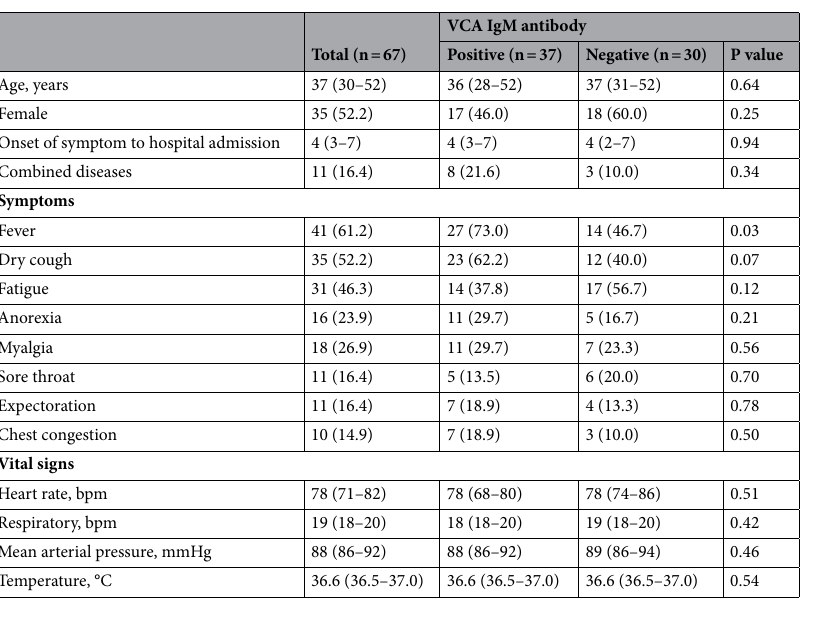
Table 1. Characteristics of Epstein–Barr virus (EBV)/severe acute respiratory syndrome coronavirus 2(SARS- CoV-2) coinfection and SARS-CoV-2 infection alone